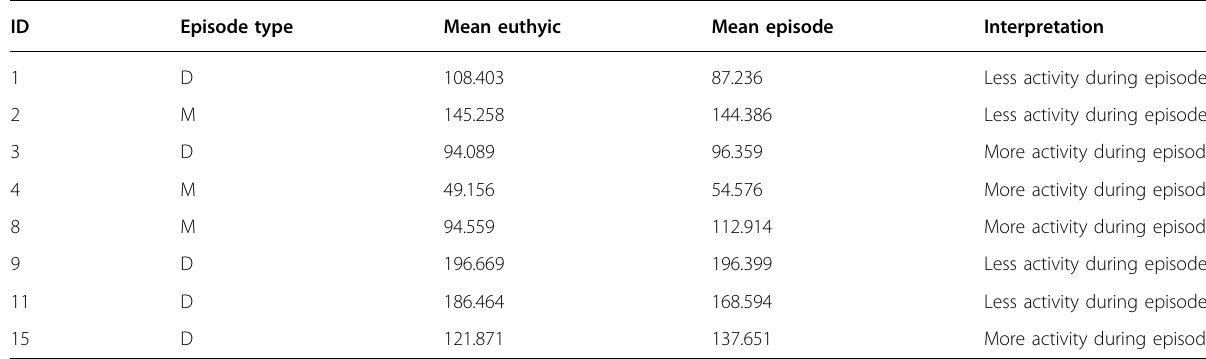
Table 3 Mean activity during periods before bipolar